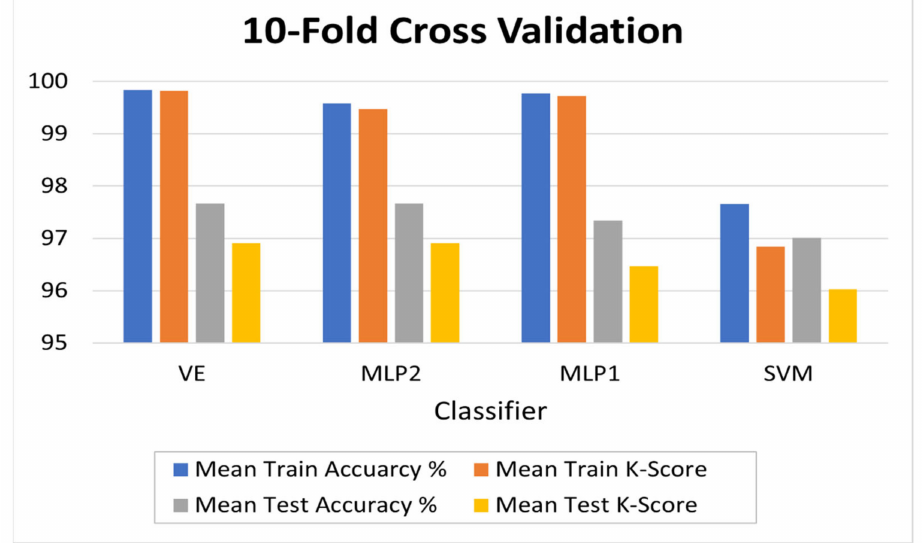
Figure 4. K-fold cross validation mean train and test, accuracy, and K-scores for the VE, MLP2, MLP1 and SVM